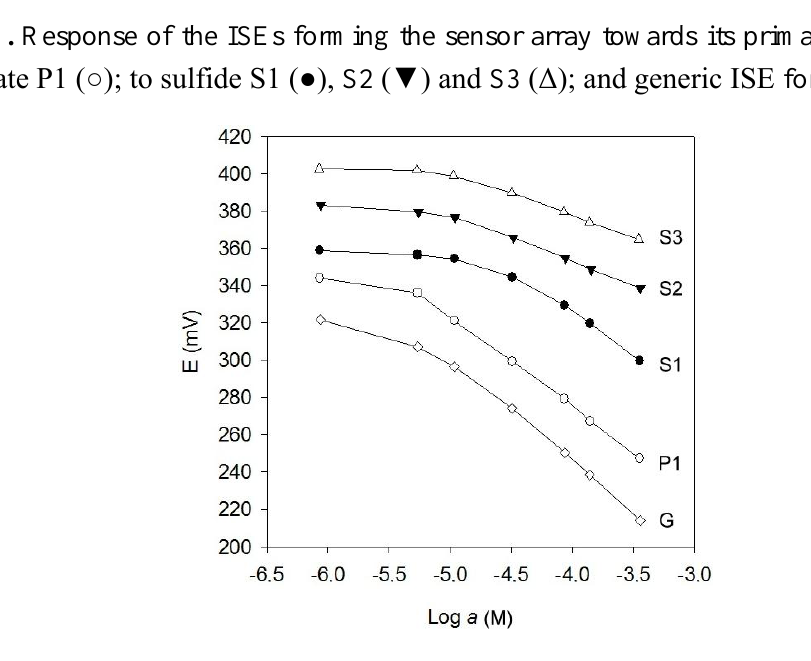
Figure 1. Response of the ISEs forming the sensor array towards its primary ion: ISEs